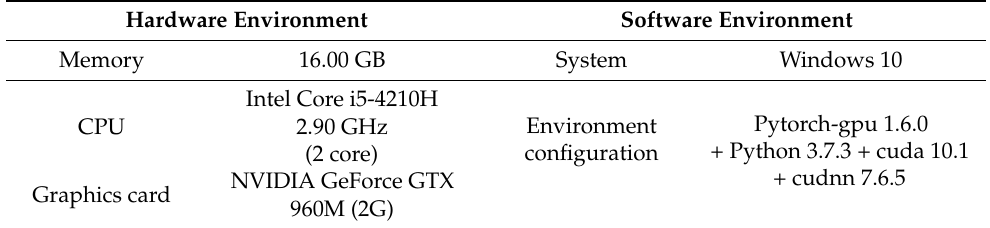
Table 3. Experimental environment.